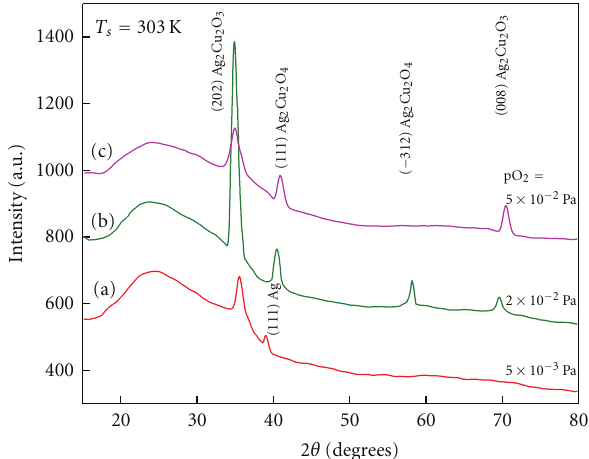
Figure 3: X-ray di ff raction profiles of Ag-Cu-O films formed at di ff erent substrate temperatures.